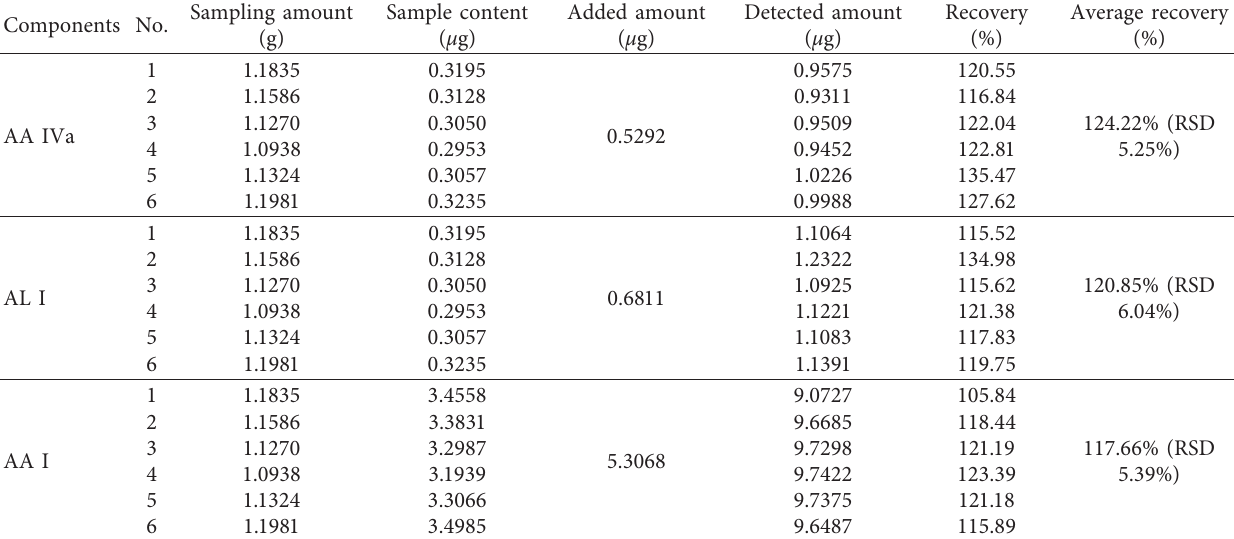
Table 4: Recovery results of AA IVa, AL I, and AA I in Long dan Xie gan Pill samples. Sampling amount Components No.